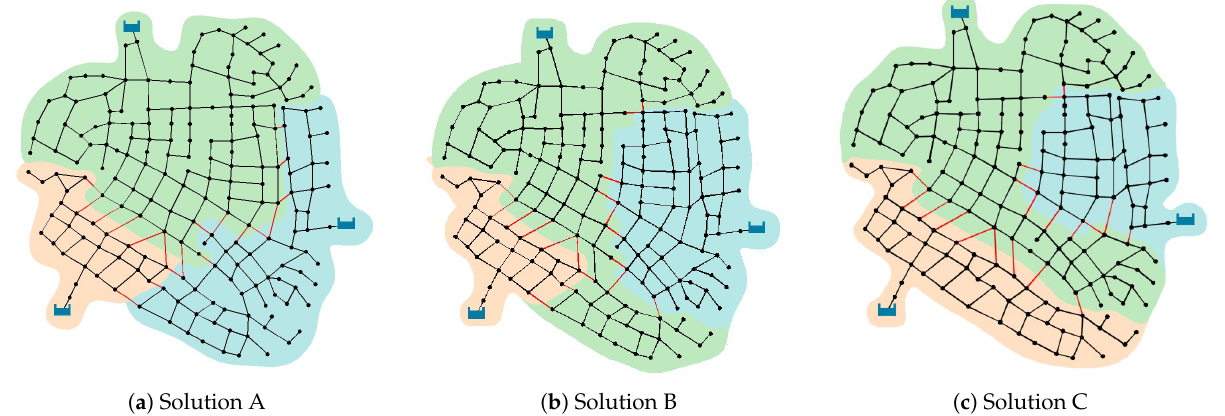
Figure 6. DMAs obtained after the second stage for each PI. ( a ) Standard deviation, ( b ) Gini coefficient and ( c ) Loss of resilience. Solutions correspond to those indicated in Figure 5 and to the gray color rows in